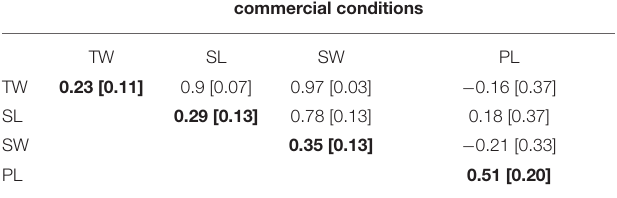
TABLE 6 | Estimated heritability ( h 2 ) of each trait (total weight [TW], shell weight [SW], shell length [SL], and parasite load [PL]) in bold along the diagonal, and genetic correlations (R g ) between traits above the diagonal, with standard deviations in brackets. h 2 and R g t rait for traits measured in F1 clams raised for 1 year in commercial